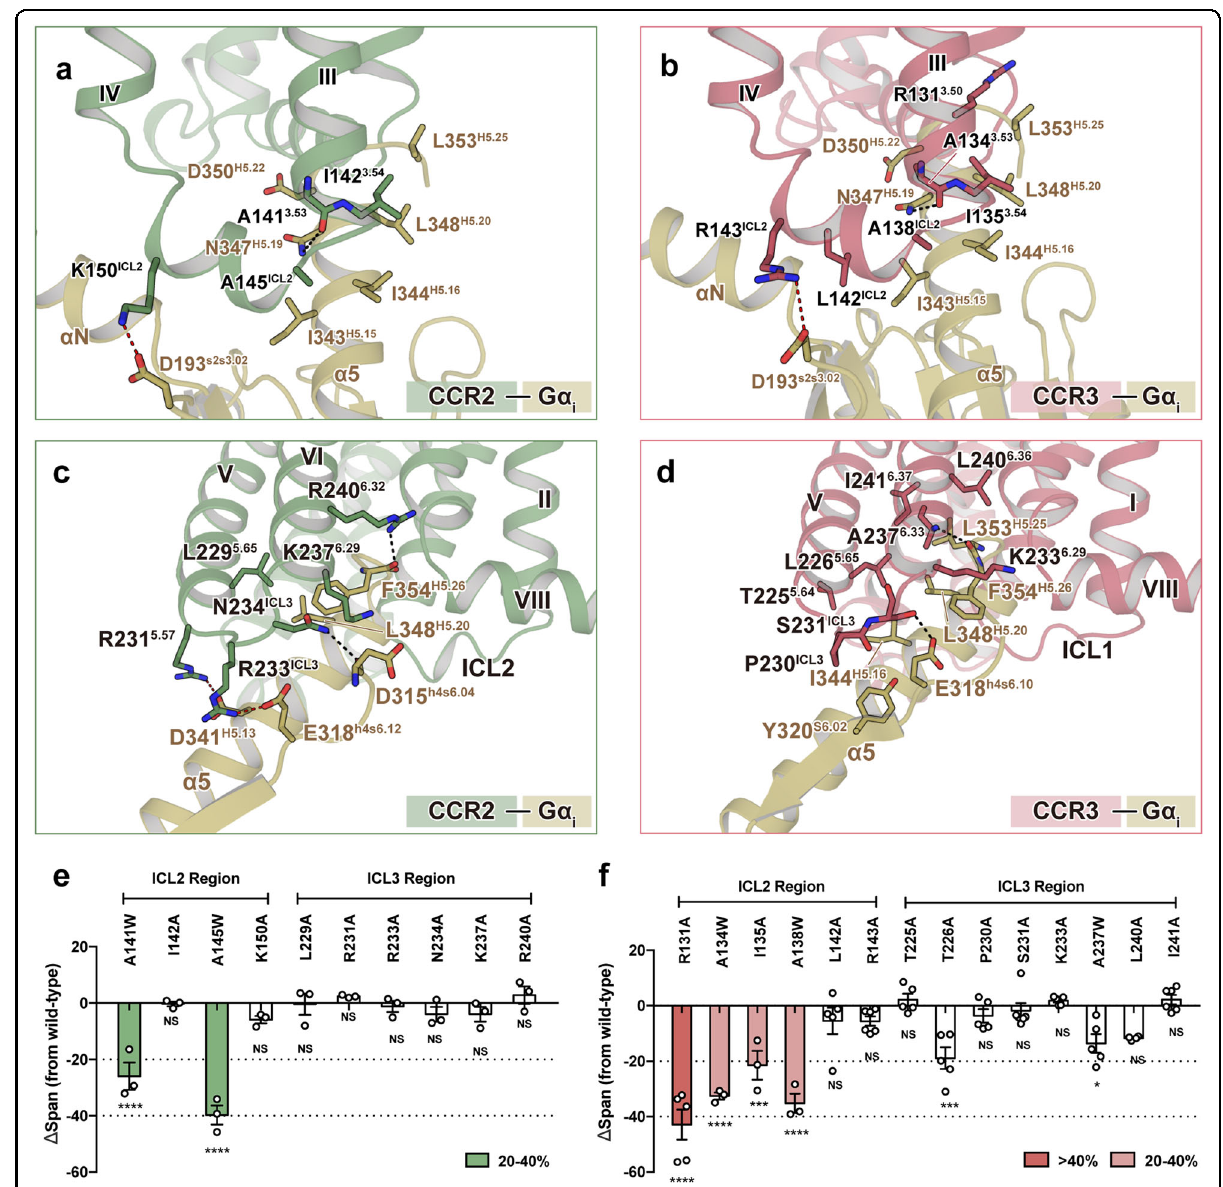
Fig. 4 Interactions between chemokine receptors and G α i1 . a , b Magni fi ed view of the interactions between TM3 and ICL2 of CCR2 ( a ) and CCR3 ( b ) with the α 5-helix of G α i . c , d Detailed interactions of TM5, TM6, and ICL3 of CCR2 ( c ) and CCR3 ( d ) with the α 5-helix of G α i . Green, CCL2-bound CCR2; pink, CCR3; yellow, G α i1 . Hydrogen bonds are depicted as black dashed lines, and electrostatic bonds are depicted as red dashed lines. e , f In fl uence of single-site mutants of CCR2 ( e ) and CCR3 ( f ) on agonist-induced cAMP accumulation. n = at least three independent experiments performed with single replicates. The statistical difference between wild-type and mutated receptor was calculated by one-way ANOVA followed by Dunnett ’ s multiple comparisons test. Superscripts indicate statistically signi fi cant difference (* P < 0.01, *** P < 0.001, **** P < 0.0001; NS no signi fi cance). Bars are colored according to the extent of effect. All data are shown as means ± SEM. See Supplementary Tables S5 and S6 for detailed statistical